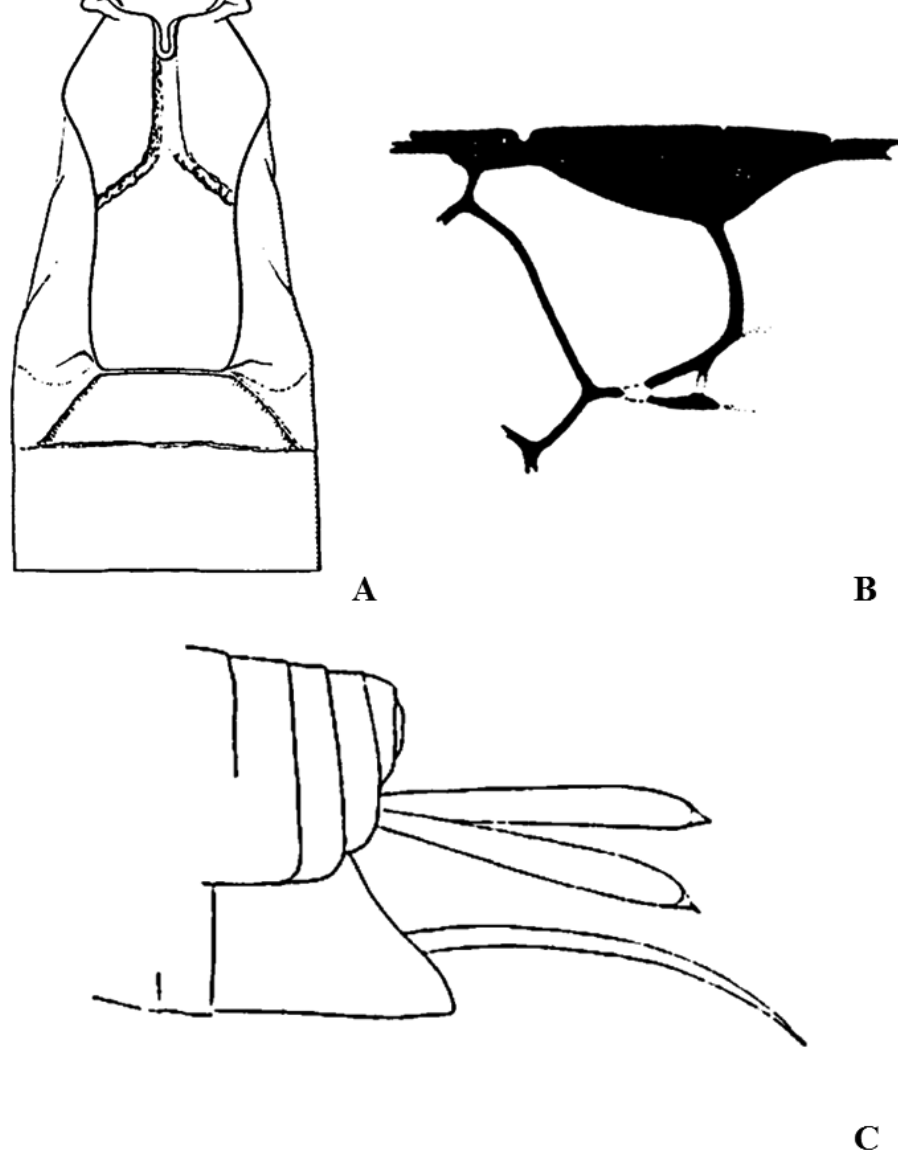
Figure 42. Ypsilonigaster pteroloba holotype based on modified drawings from the original descriptions of the species (de Saeger 1944). A Tergites 1 to 3 B Fore wing details of pterostigma and nearby veins C Hypopygium, ovipositor and ovipositor sheaths. divided in three areas by a strong sulcus shaped as an inverted “Y”; T1 L 1.38 × T1 W at posterior margin. T2 subtriangular; T2 width at posterior margin 3.05 × T2 L Body measurements (mm). F2 L: 0.25; F3 L: 0.26; F14 L: 0.23; F15 L: 0.21;